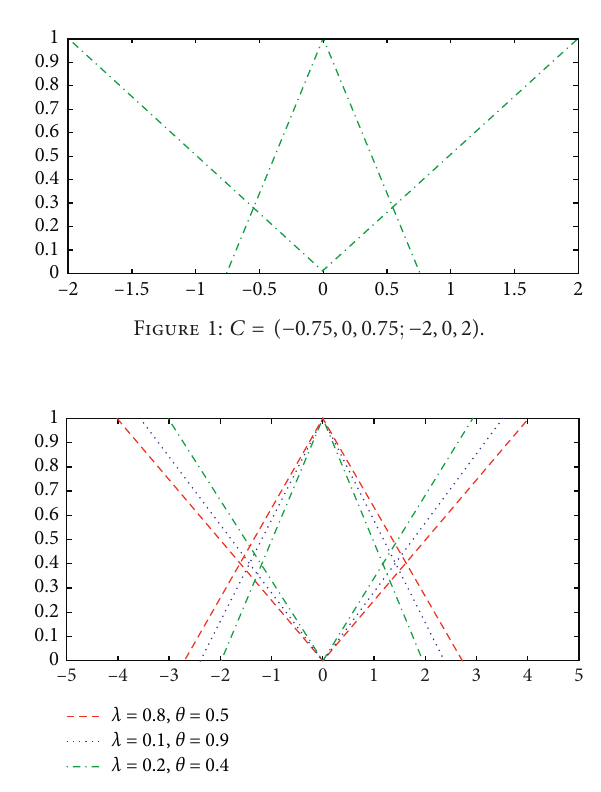
, ϕ 〉( x,y ) at different values of ( λ , θ ) . 1 2